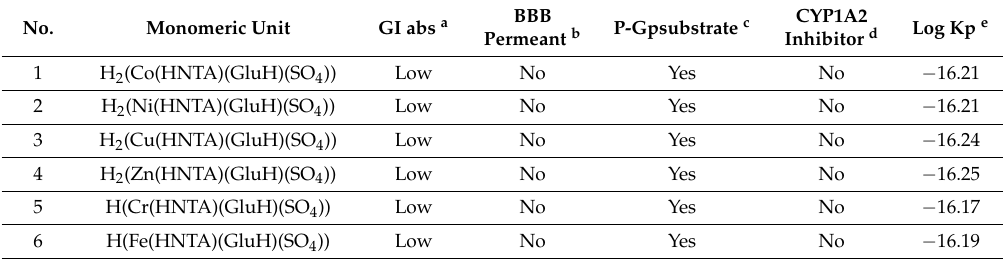
Table 7. Pharmacokinetic predictions of the selected compounds